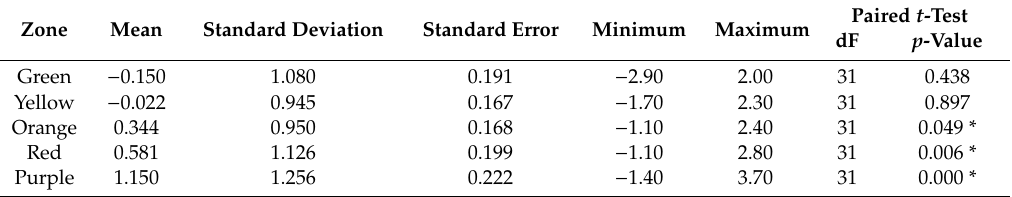
Table 8. Variation of hand skin temperature ( ◦